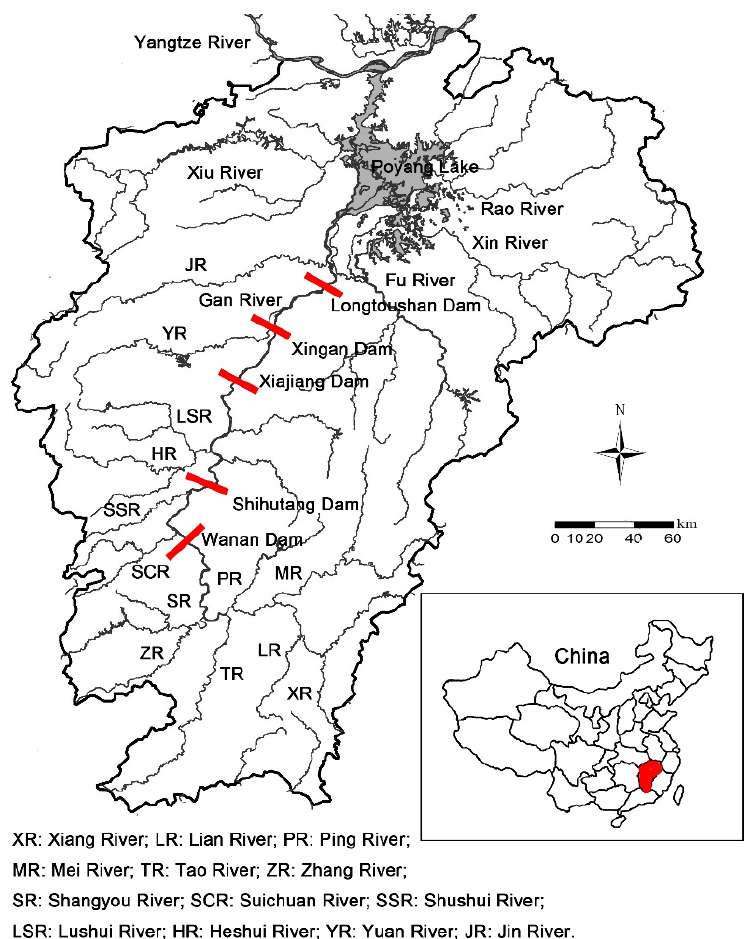
Figure 1. Map showing the study area and locations of river sites in the Gan River Basin, China. The red symbols represent the dams.